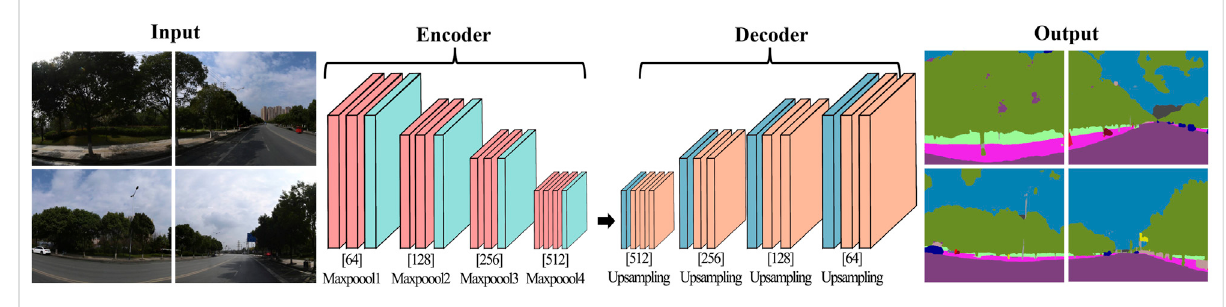
FIGURE 6 Illustration of semantic segmentation techniques-based streetscape attribute variables calculation